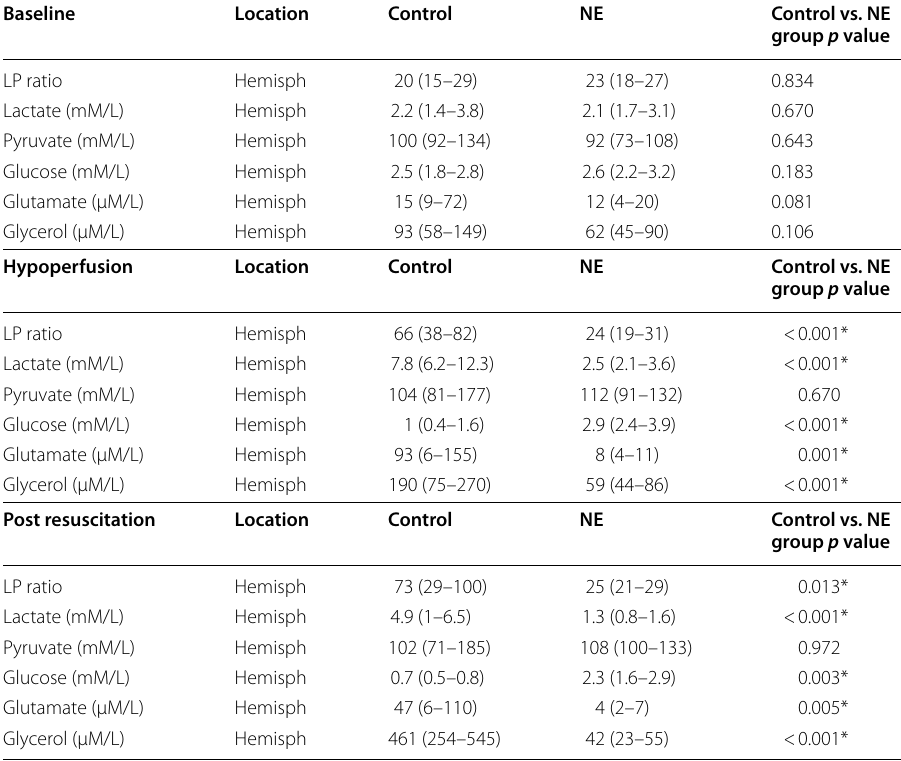
Values are divided into three-time intervals and expressed as median (interquartile range). Control n Test statistics performed with mixed effectt model *Statistical significant p value <